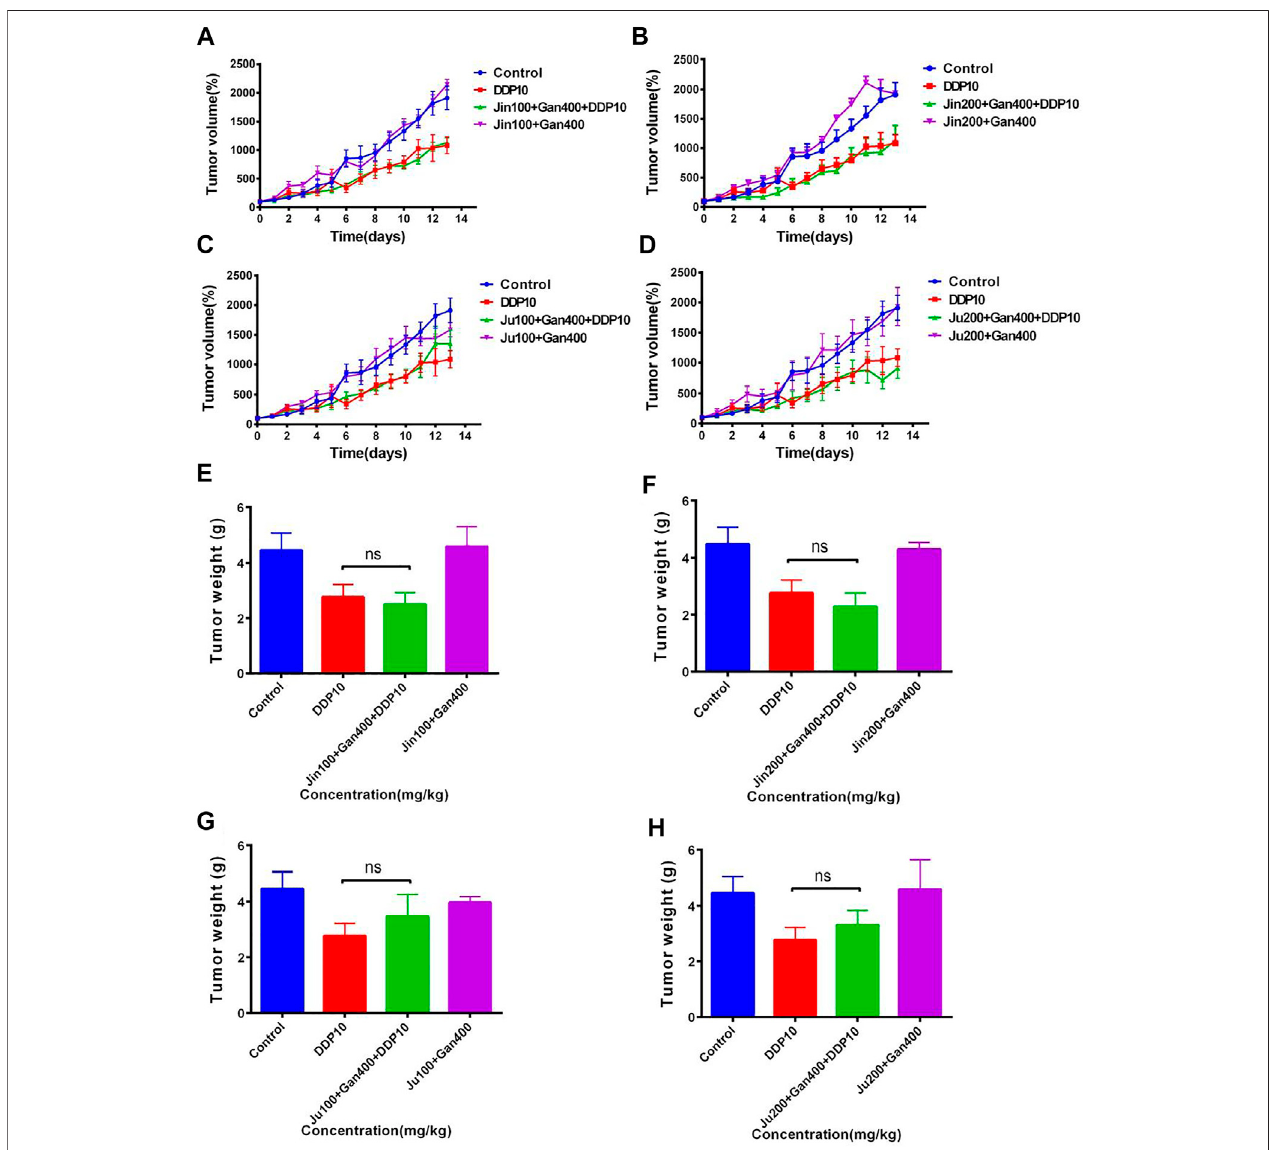
FIGURE 4 | The effect of two Chinese medicine formulas on the antitumor activity of DDP in vivo . (A-B,E-F) Dose of Ju + Gan on the antitumor activity of DDP in mice. (C-D,G-H) Dose of Jin + Gan on the antitumor activity of DDP in mice.